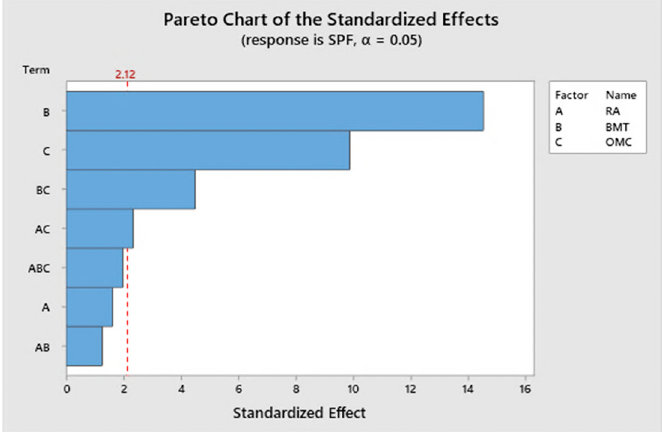
Figure 6. Pareto chart representation of the effect of isolated and combined variables on the in vitro SPF of the formulations.